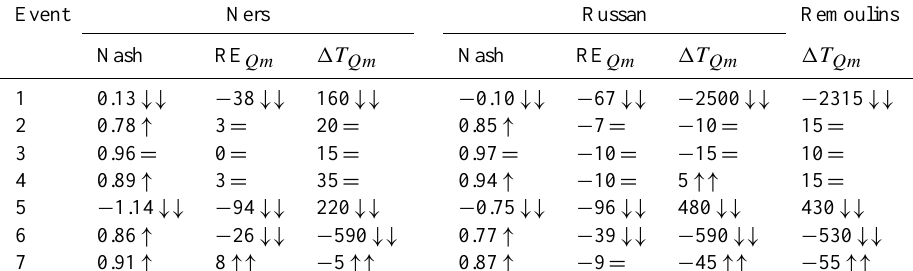
Table 10. SV OBS option results. Performance indexes at the Ners, Russan and Remoulins stations. The symbols on the right of the indexes characterise the gaps compared with the COUPL MOD option. ↓↓ : deterioration of more than 50%; ↓ : deterioration of between 5 and 50%; ↑ : improvement of between 5 and 50%; ↑↑ : improvement of more than 50%; = : close values, within ± 5%. Symbol also attributed to